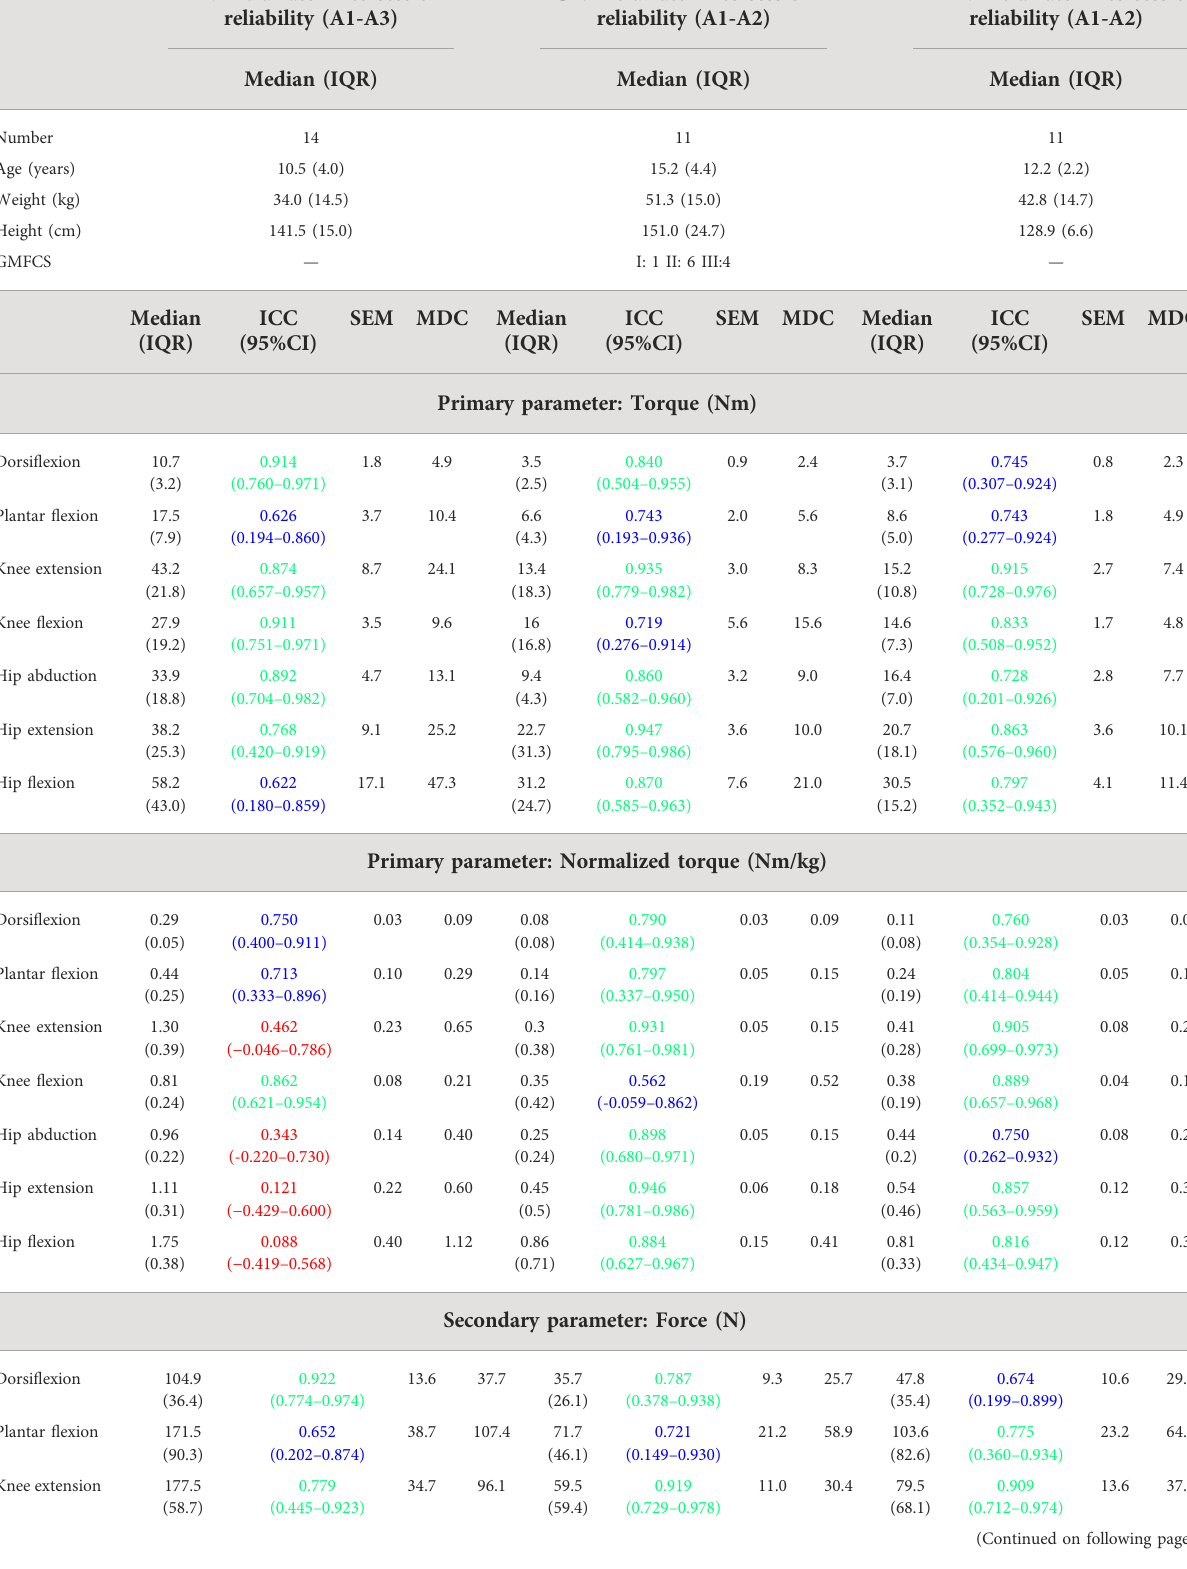
TABLE 2 Intra-rater intersession reliability results of the TD children as well as children with CP and DMD included in the reliability study. TD: Intra-rater intersession reliability